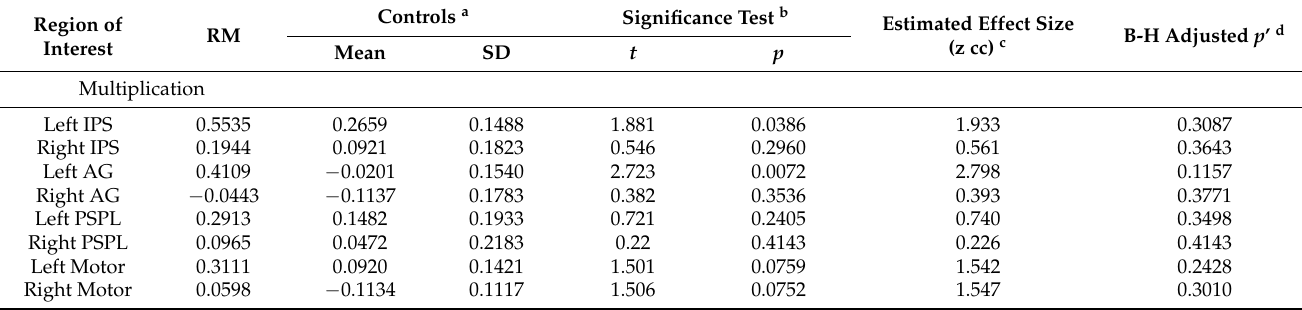
Table 5. Mean percentage signal change for RM and the control group during multiplication and subtraction by